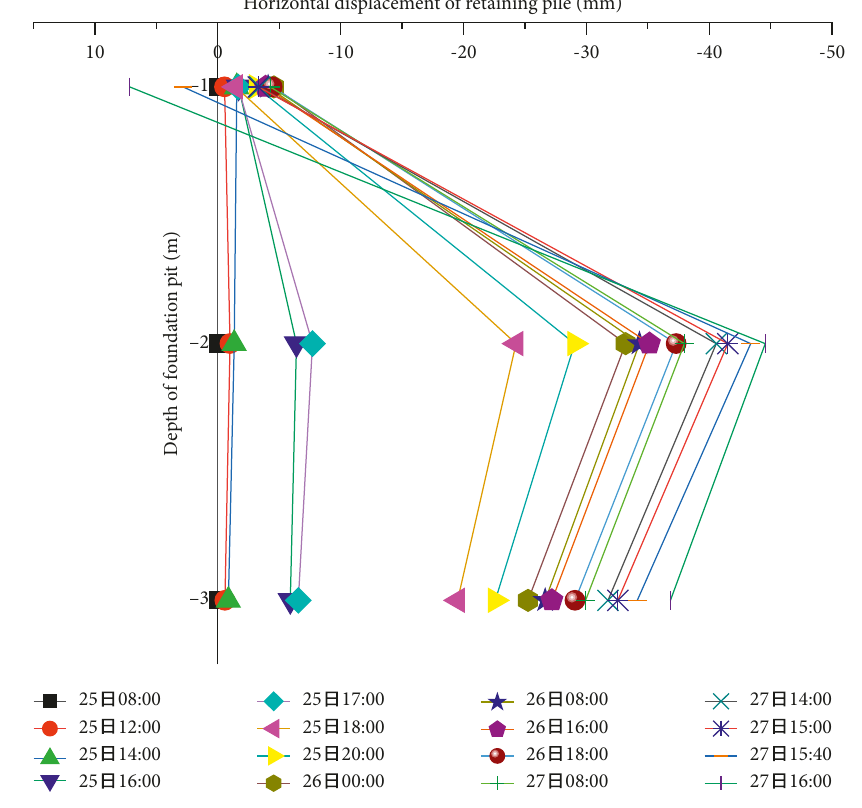
Figure 10: Lateral displacement of steel pipe pile with lap joint connection.